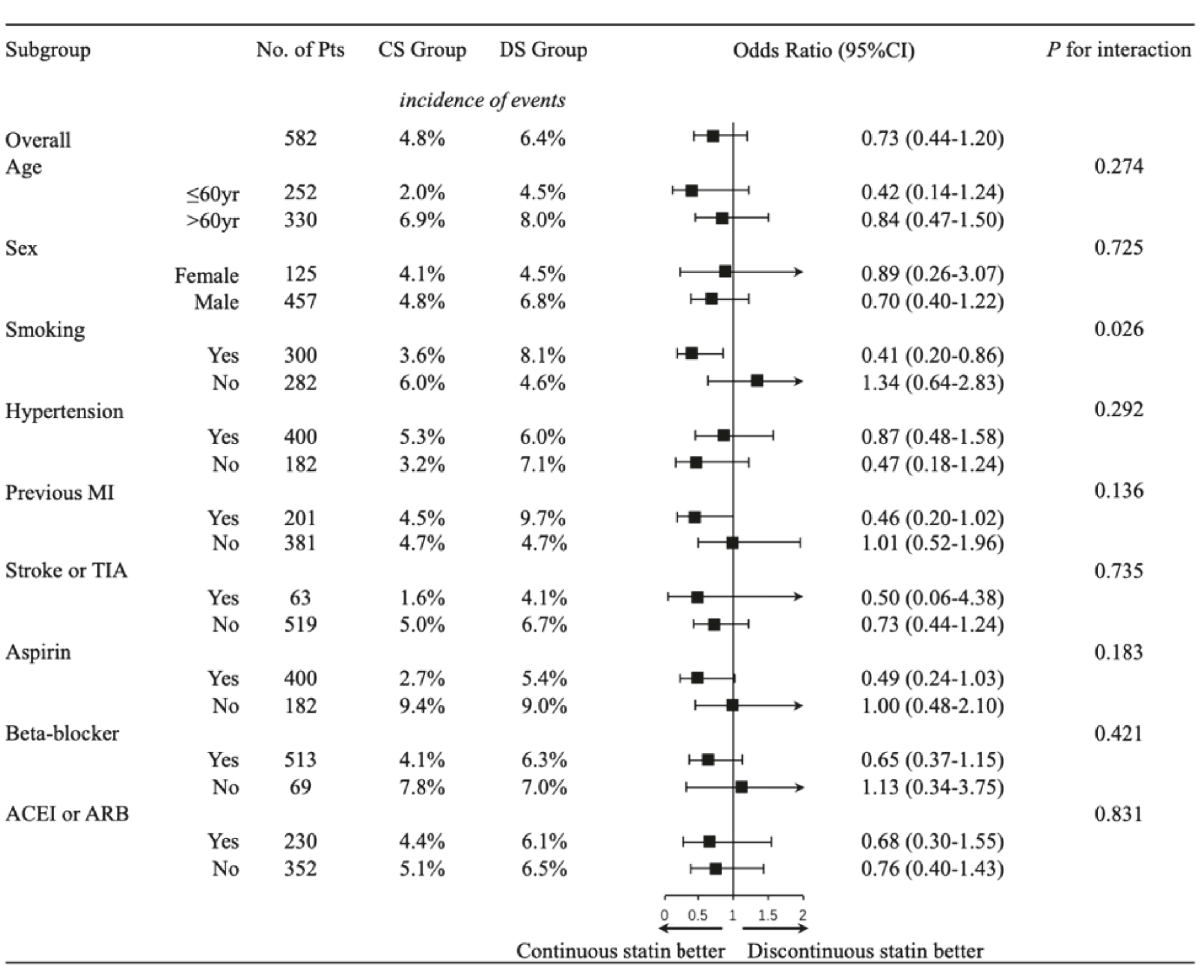
Figure 1: Effect of Perioperative Statin Therapy on Postoperative Graft Occlusion, Overall and According to Prespecified Subgroups Following IPW Adjustment . Shown are odds ratios for the incidence of graft occlusion after off-pump CABG (assessed by MSCTA) among patients with perioperative continuation of statin therapy (CS group) as compared with those with discontinuation of statin therapy (DS group). For each prespecified subgroup, after IPW propensity-score adjustment, squares represent odds ratios and horizontal lines represent 95% confidence intervals, with values and results of the 푃 for interaction significance test presented alongside. A square to the left of the vertical line indicates a benefit associated with perioperative continuous statin use, but the benefit is significant at the 5% level only if the horizontal line does not overlap the vertical